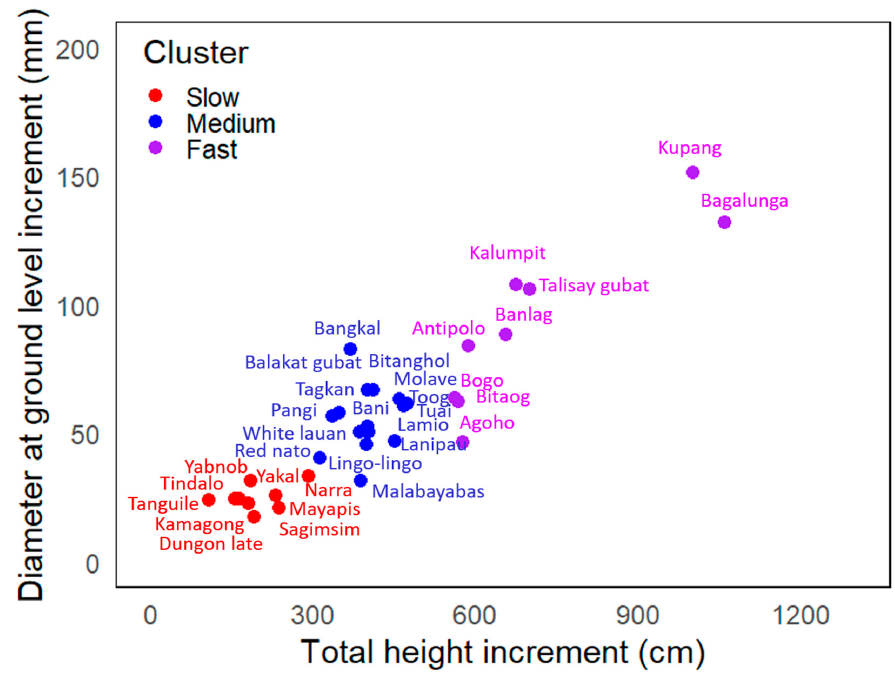
Figure 3. Result of K-means clustering analysis for 33 native domesticated species based on total height and diameter at ground level (dgl) increments obtained at the end of measurement period in 2018. Each cluster was assigned with colored circles and species local names were used to label each datapoint. Table 2. Clustered species and their annual average total height and diameter at ground level increments from 2014 to 2018 (Years 1 to 4). Survival rate was determined at the end of the measurement period in 2018.